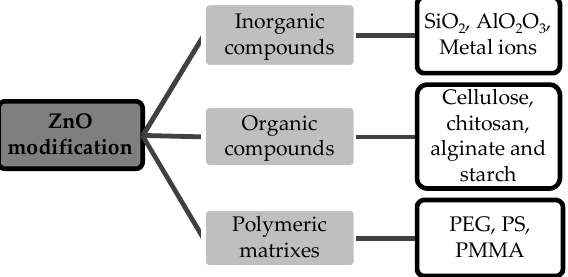
Figure 1. Used agents for surface modification of ZnO. PEG = polyethylene glycol; PS = polystyrene; PMMA = polymethylmethacrylate.